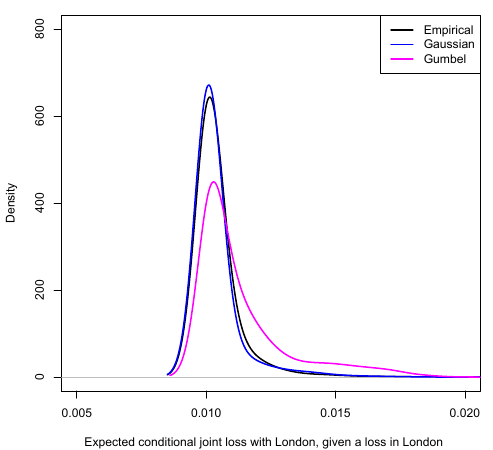
Figure 8. For all land locations in the European domain, the condi- tional expected joint loss with London, given a loss has occurred in London (Eq. 7), calculated empirically and using the Gaussian and Gumbel copula